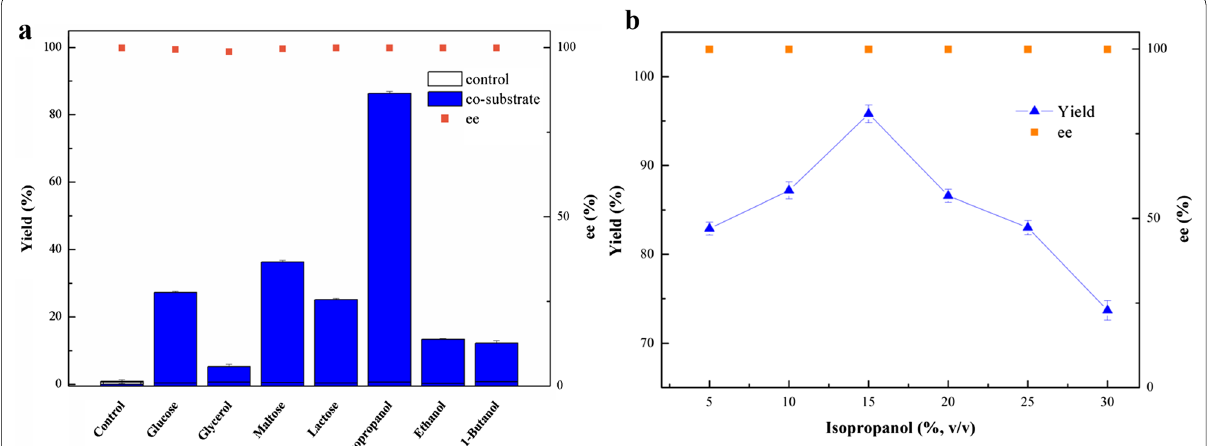
Fig. 1 Effects of different co-substrate ( a ) and various isopropanol proportion ( b ) on the ( R )-MTF-PEL production with recombinant E. coli cells in PBS buffer medium. Reaction conditions: 50 mM 3’-(trifluoromethyl)acetophenone ( a, b ), 10% (w/v) different co-substrate ( a ), 10.57 g (DCW)/L recombinant E. coli cells, PBS buffer (pH 7.0) ( a, b ), 30 ℃ , 200 rpm, 12